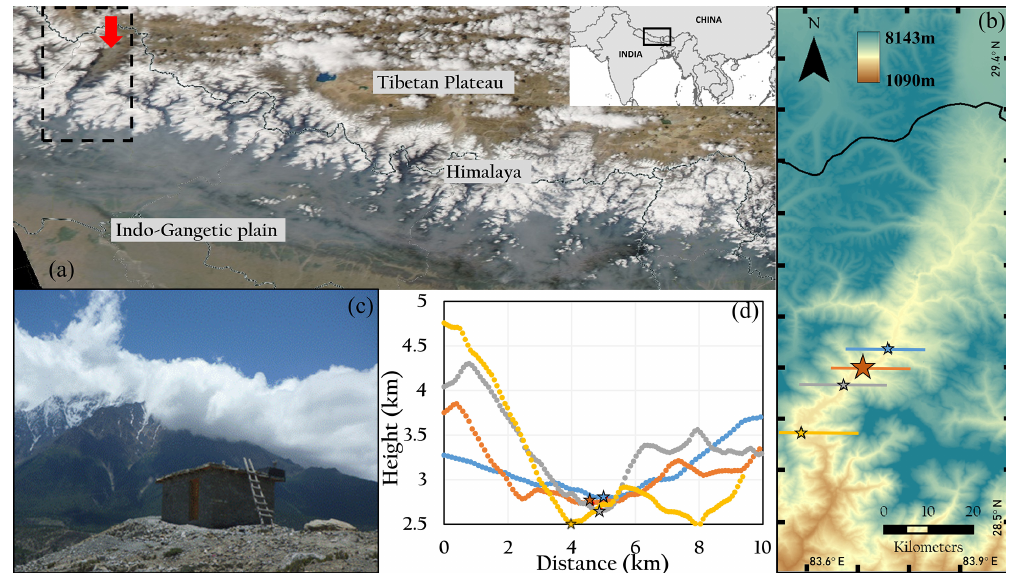
Figure 1. (a) NASA Worldview image from 4 November 2014 depicting thick haze intruding the Himalayan foothills with a red arrow over the KGV. Inset map in the top-right corner of (a) shows the location of the Worldview image. Dashed box shows the location of (b) . (b) Expanded scale of the KGV showing station locations of Lete (LET_AWS) near the entrance of the valley (yellow star); Marpha (MPH- AWS) in the core region (gray star); the Jomsom (JSM_STA) sampling station for BC and O 3 and the two associated AWS sites (JSM_1 and JSM_2) in the core region (orange star); and Eklobhatti (EKL_AWS) near the exit (blue star). (c) The atmospheric observatory at Jomsom (JSM_STA) (28.87 ◦ N, 83.73 ◦ E, 2900ma . s . l . ). (d) Valley cross-sectional elevation profile at the station